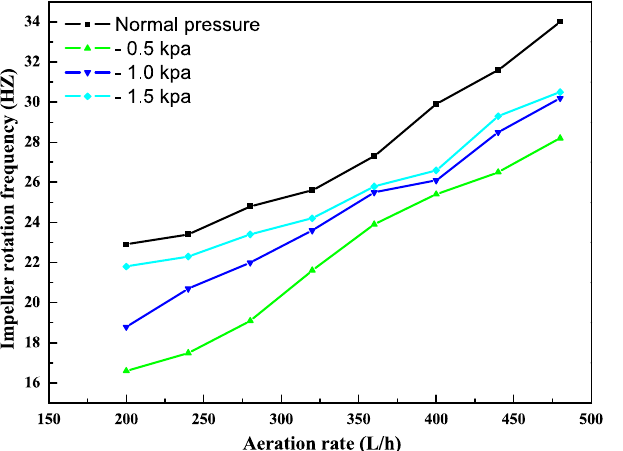
Figure 5. Relationship between impeller frequency and aeration rate under different vacuum